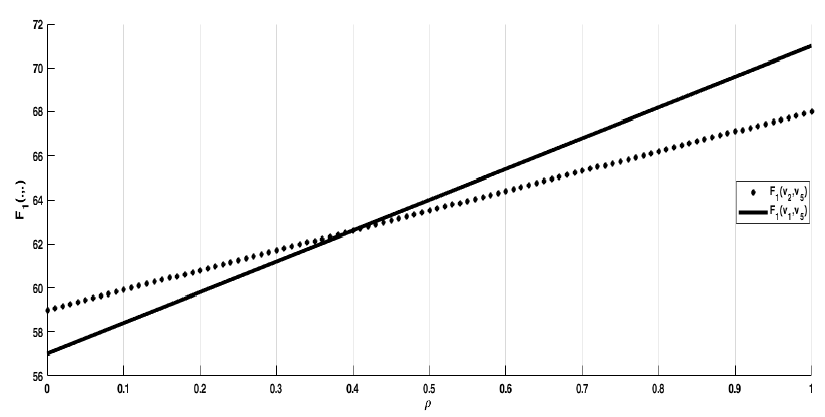
Fig. 4. The value of objective functions in example 2 respect to 𝟎 ≤ 𝝆 ≤ 𝟏